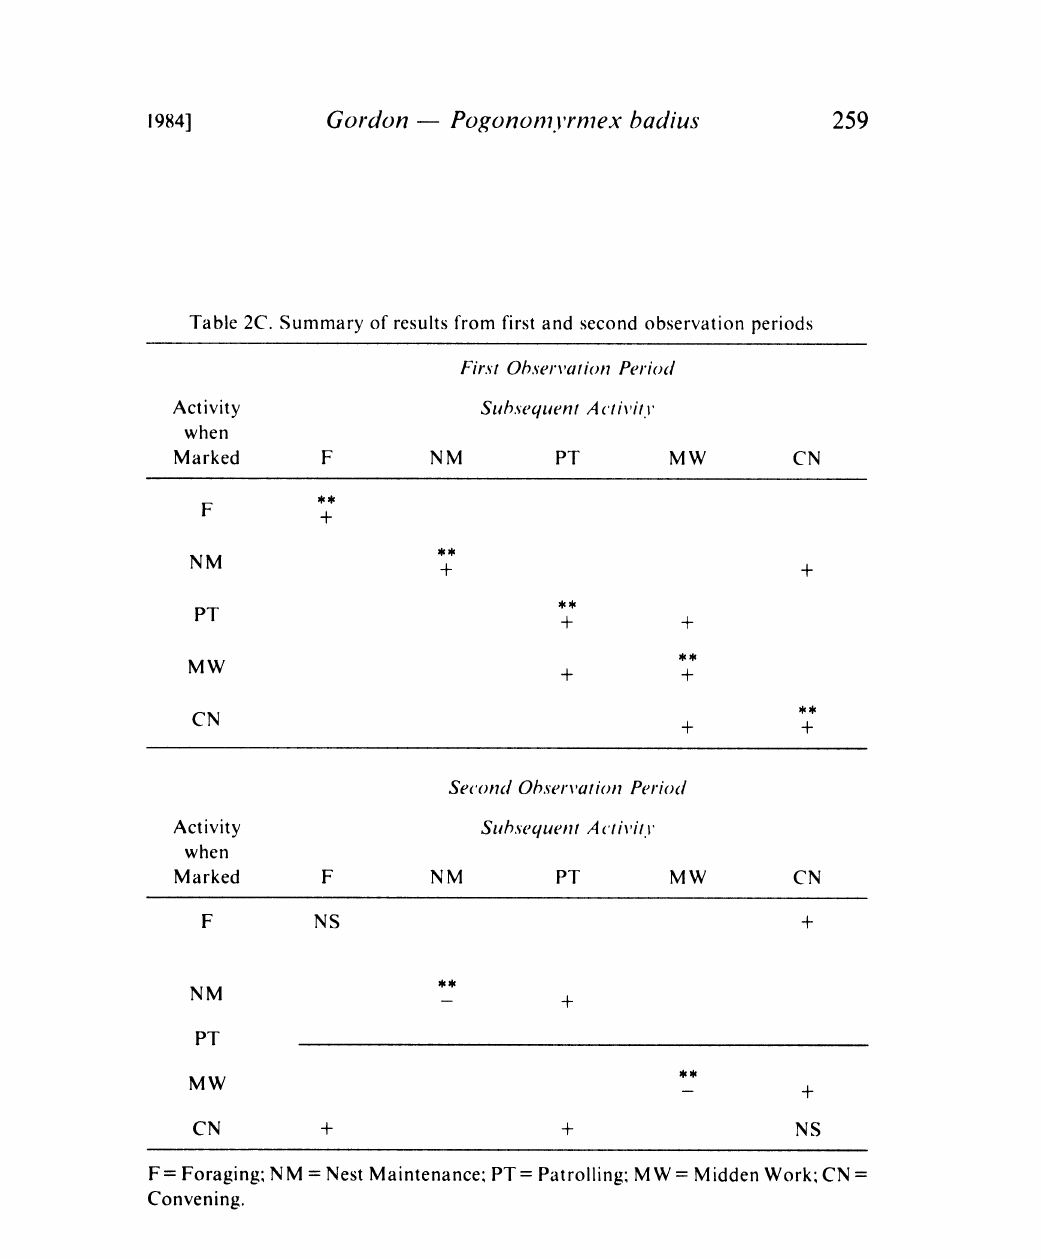
Table 2C. Summary of results from first and second observation periods